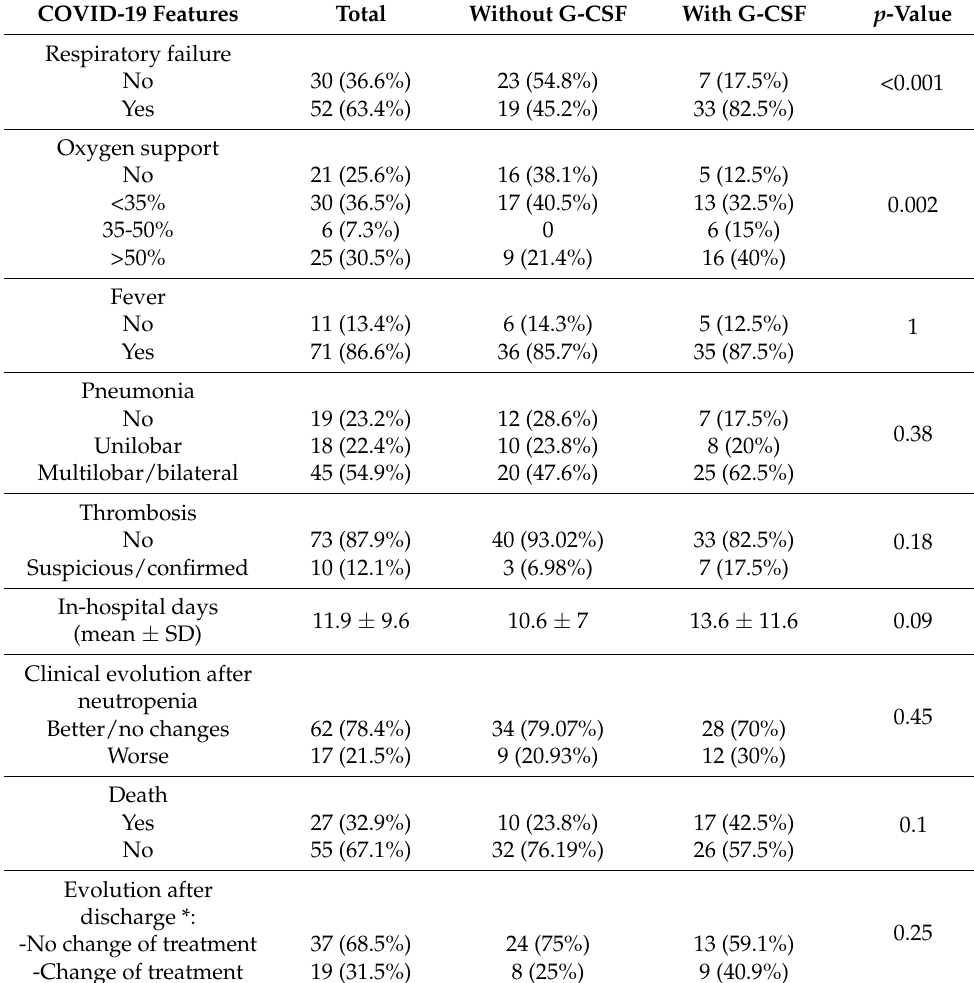
Table 2. COVID-19 features of all patients included: total and split by G-CSF treatment. No attempt was made to impute missing values present in some variables. p value of association with G-CSF treatment is also